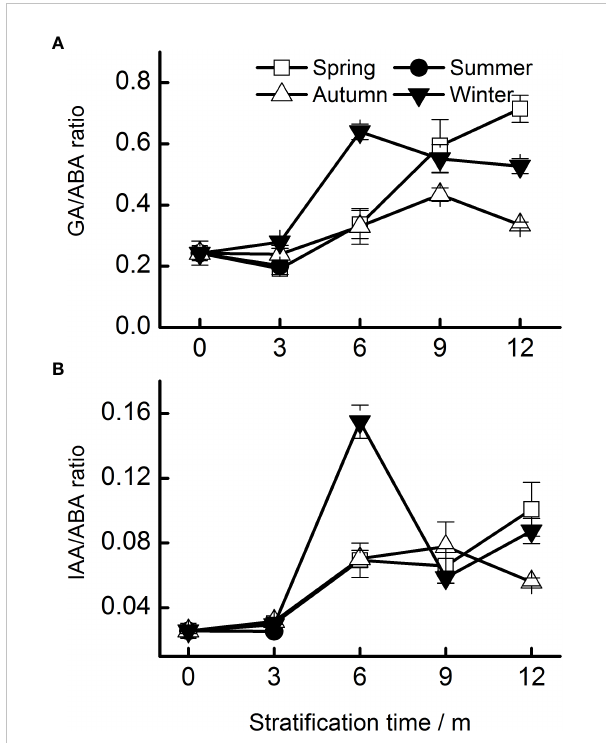
FIGURE 5 Ratios of hormones ( A , GA – ABA; B , IAA – ABA) of Taxus chinensis var. mairei seeds strati fi ed at four seasonal temperature regimes. The vertical bars represent standard errors of the mean (n = 3). ABA, abscisic acid; GA, gibberellic acid; IAA, indole acetic